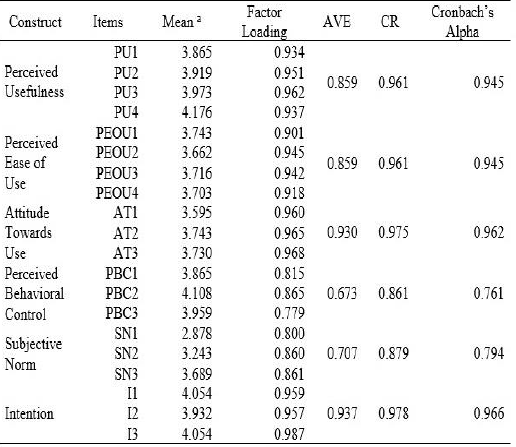
Table 2: Results of Measurement Model